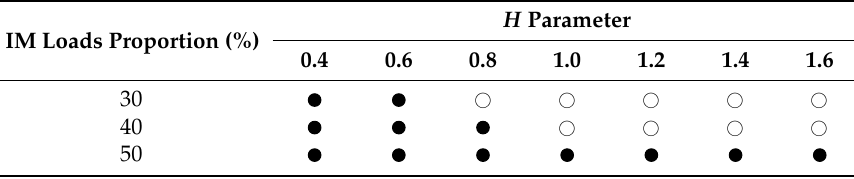
Table 2. Result of induction motor loads proportion and H parameter changes.